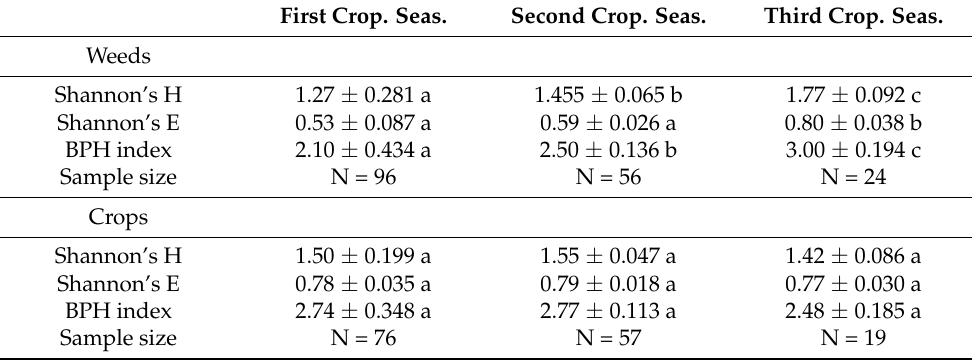
Table 5. Shannon’s H, Shannon’s E and inverse BPH dominance index and the standard error values (SE) of weeds and crops in the perennial mixture over the experimental years. Significantly different results ( p < 0.05, Tukey test) are marked with different letters. First Crop. Seas. Second Crop. Seas. Third Crop. Seas.